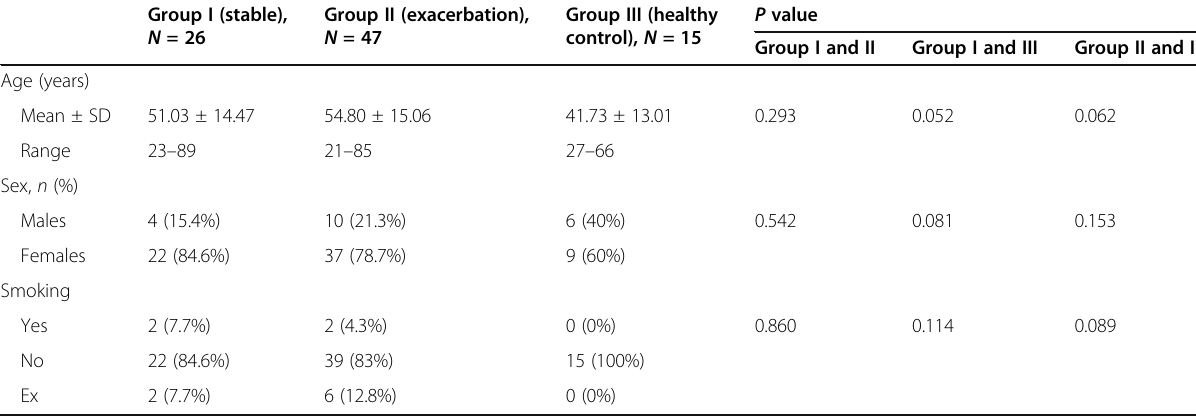
Table 1 Demographic data of all studied groups